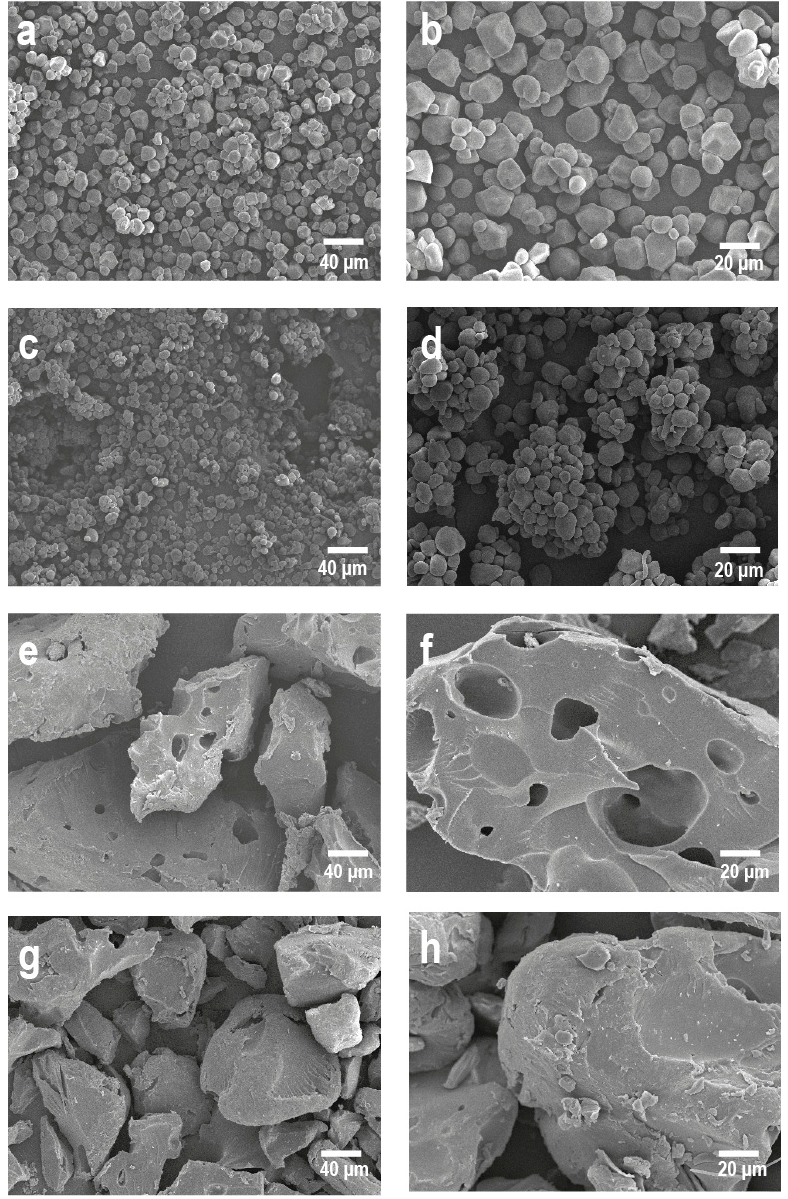
Figure 4. Micrographics SEM of cornstarch ( a —200×, b —750×), standard resistant starch 52% ( c —200×, d —750×) and extruded starch ( e / g —200×, f / h —750×).